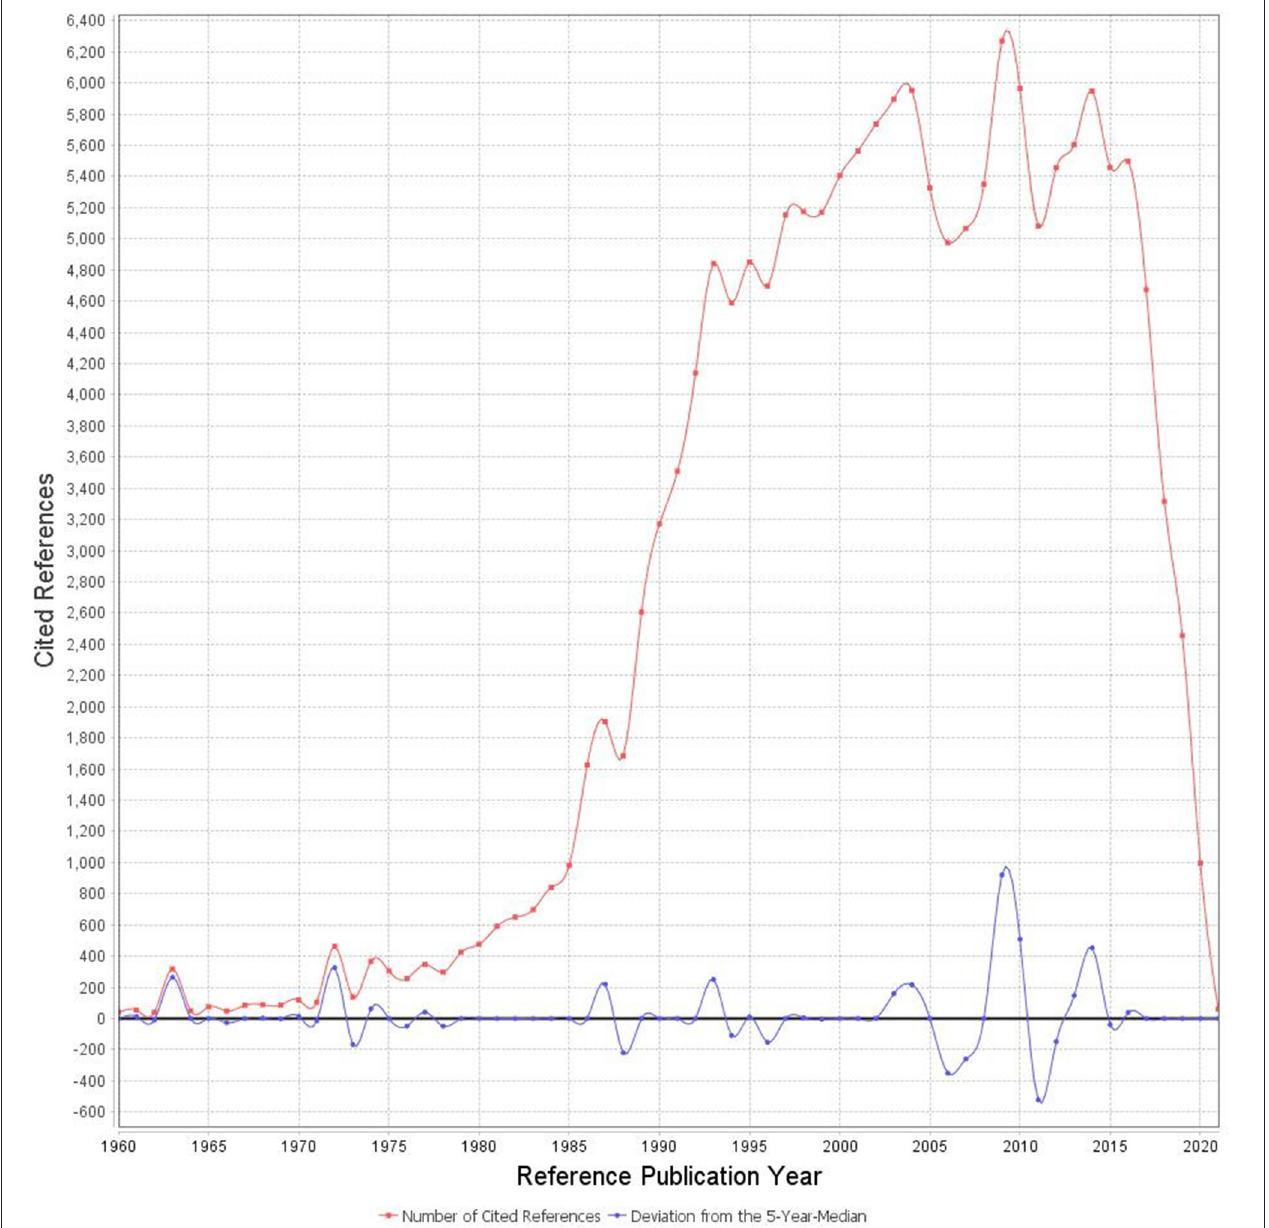
FIGURE 2 | The spectrogram of the lipoprotein(a) research literature production.